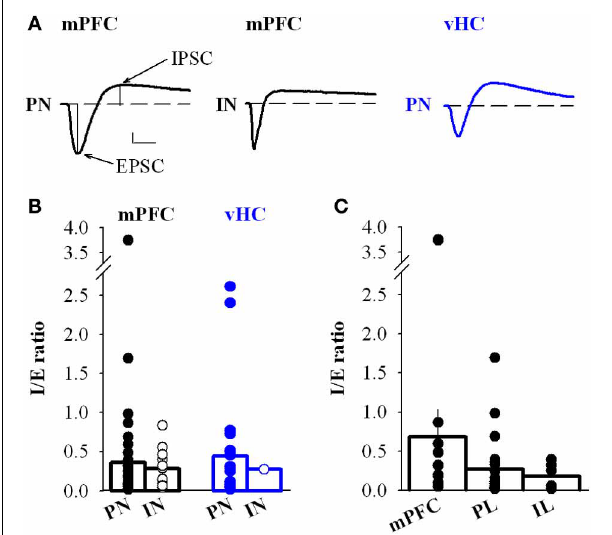
FIGURE 7 | Inhibition to excitation ratio of mPFC and vHC inputs onto BA neurons. (A) Example traces of biphasic EPSC/IPSC sequences recorded at − 50mV in BA principal neurons (PN) and interneurons (IN) receiving input from either mPFC (black traces) or vHC (blue trace). Scale bar: 50pA/10ms. (B) Summary graph of the inhibition to excitation ratio (I/E ratio) in PNs and INs for mPFC (black) and vHC inputs (blue), all values are in Table 2 (all PNs) and Table 5 (all INs). Individual data points illustrate the high variability of I/E ratios. No significant differences were found between PNs and INs receiving mPFC input ( p = 0 . 699). (C) Summary graph of the I/E ratio in PNs receiving inputs from subregions of the mPFC: Ratios for mPFC (undefined mPFC) 0.69 ± 0.35, n = 10; PL 0.27 ± 0.08, n = 23; and IL 0.18 ± 0.07, n = 6. No significant differences were found